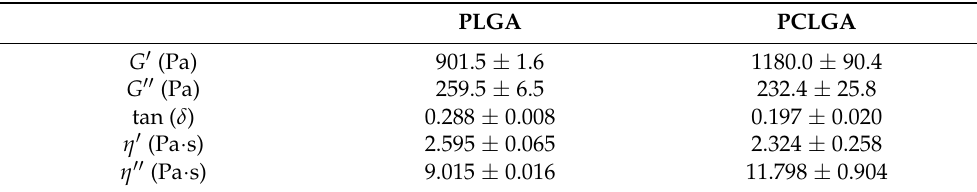
Table 2. Storage ( G (cid:48) ) and loss ( G (cid:48)(cid:48) ) moduli, tan ( δ ), dynamic ( η (cid:48) ) and storage ( η (cid:48)(cid:48) ) viscosities for PLGA and PCLGA solutions described in Table 1, measured at 100 rad/s.